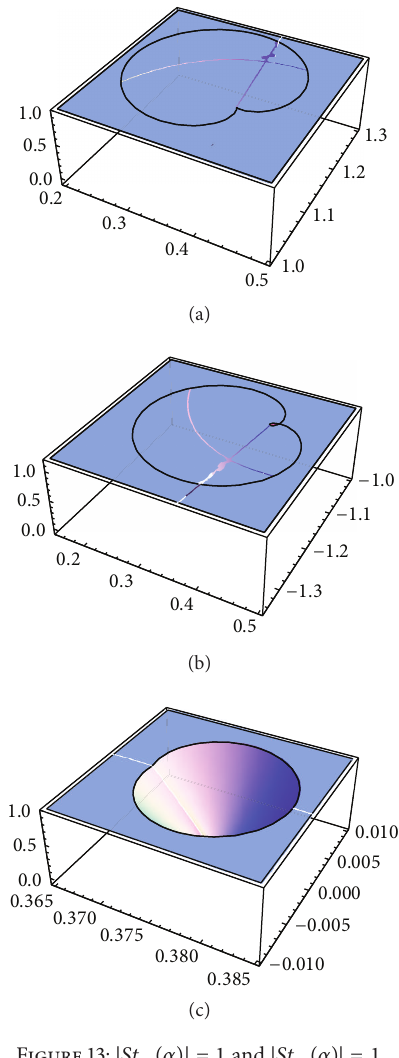
Figure 13: |𝑆𝑡 12 (𝛼)| = 1 and |𝑆𝑡 34 (𝛼)| = 1 .